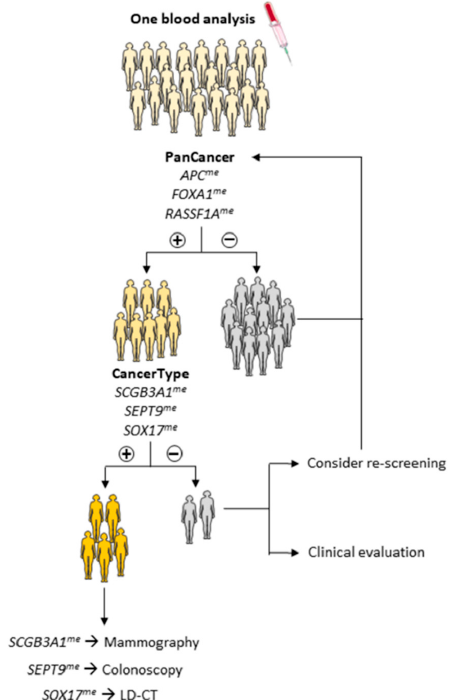
Figure 4. Schematic representation of a proposed algorithm for screening and management of breast, colorectal and lung cancers using the methylation tests. If “PanCancer” panel was positive, “CancerType” panel would be performed in order to determine the cancer type